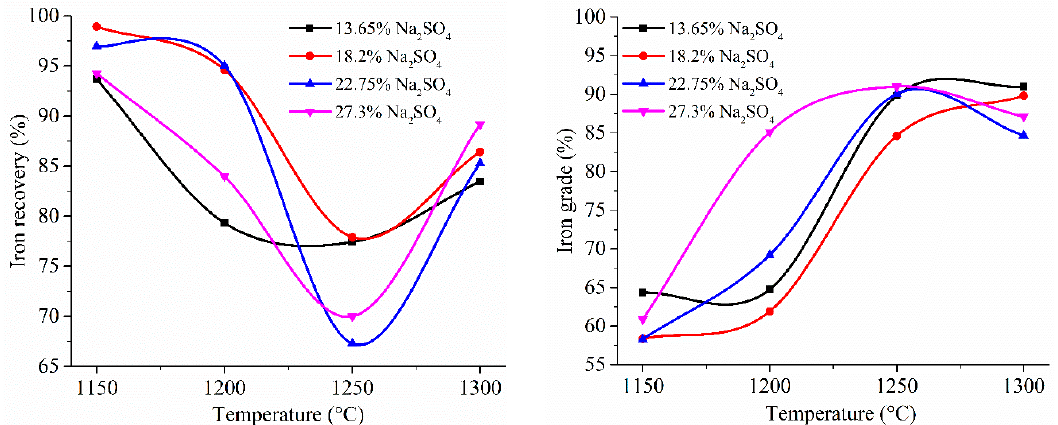
Figure 9. E ff ect of the roasting temperature on iron recovery ( a ) and iron grade of magnetic concentrate ( b ) of the sample B roasted during 180 min.